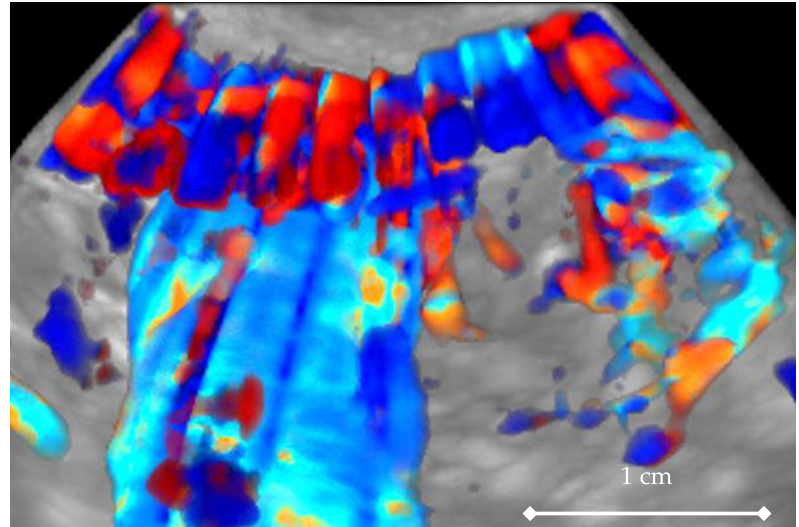
Figure 12. Color Doppler 3D magnified image of the transverse vessel (upper part of the image). The influence of periodically variable (systolic/diastolic) blood flow is visible as linear vertical irregularities in color. Creating a single record with ultrasound beam moving from left to right of the screen takes about 10s which covers about 10 heartbeat cycles.